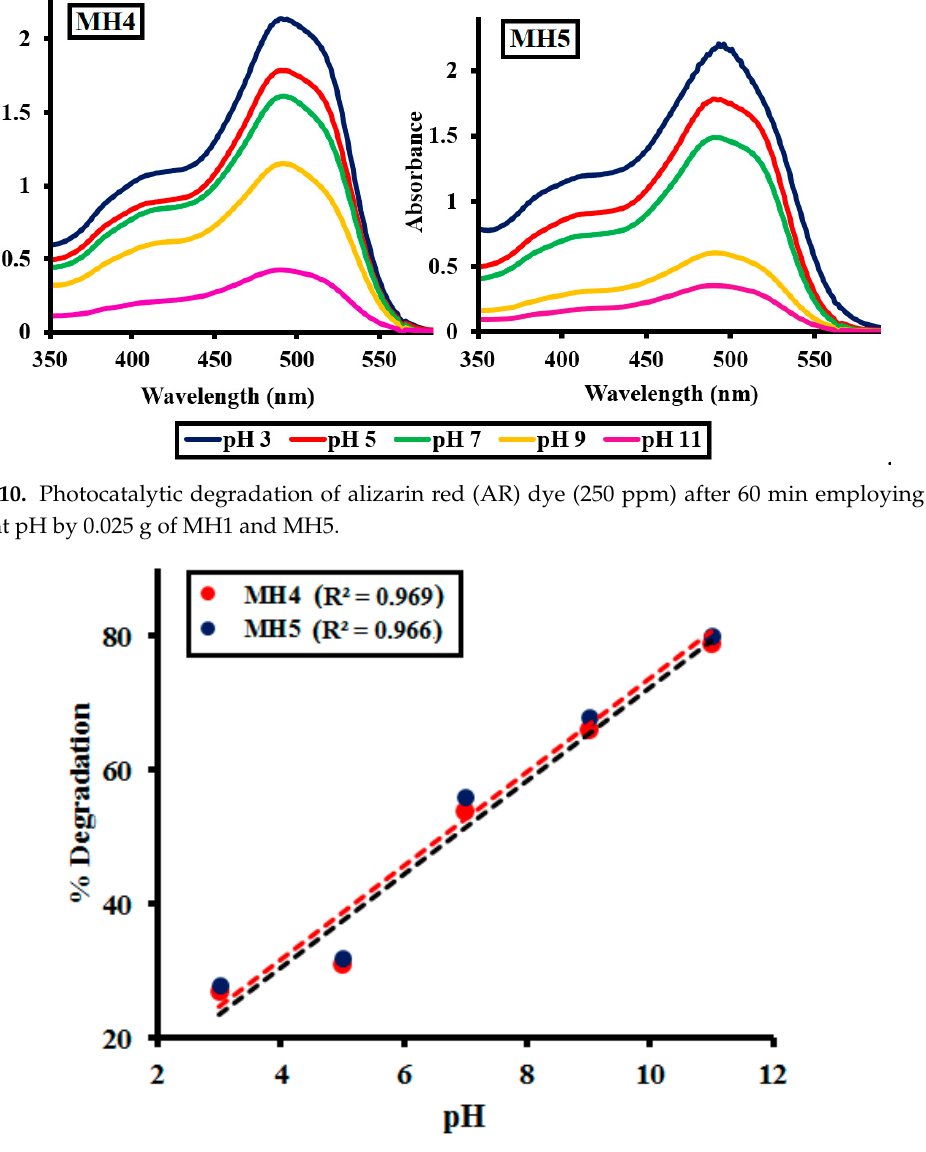
Figure 11. Correlation between different pH and percentage degradation of alizarin red (AR) dye (200 ppm) by 0.02 g of nanomaterials MH1 and MH5 after 60 min of photocatalytic activity.